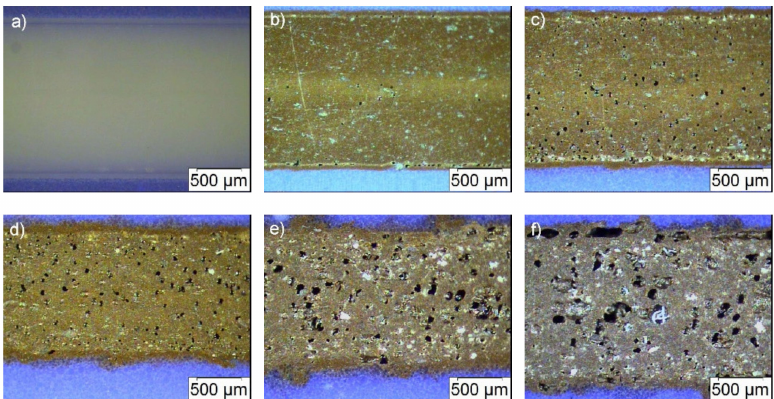
Figure 4. Microscopic images of polished longitudinal cuts with increasing filler content: Upper row, from left to right: Pure ABS ( a ), 10 vol.% ( b ) and 20 vol.% ( c ); lower row: 30 vol.% ( d ), 35 vol.% ( e ) and 40 vol.% ( f )